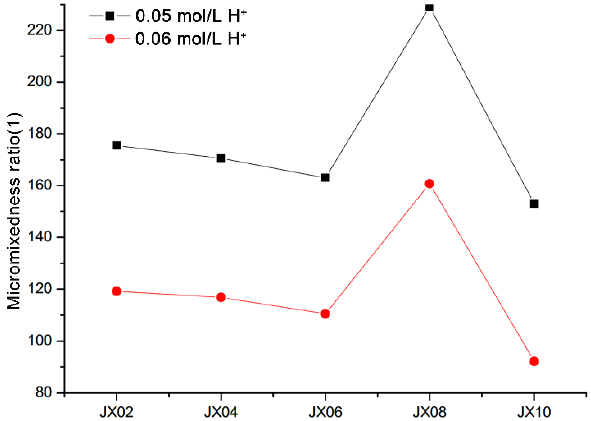
Figure 7. Micromixedness ratio of the micro reacting pipe with different determining size.